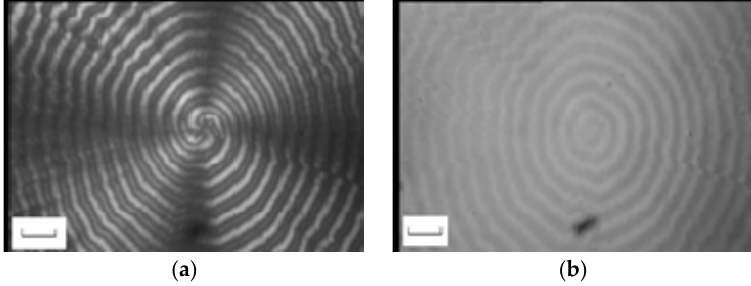
Figure 15. A PHBV banded spherulite showing spirals under cross polarized optical microscope ( a ) and concentric bands observed without polarizer and analyzer ( b ). The scale bar is 10 microns. Adapted from Ref. [14].